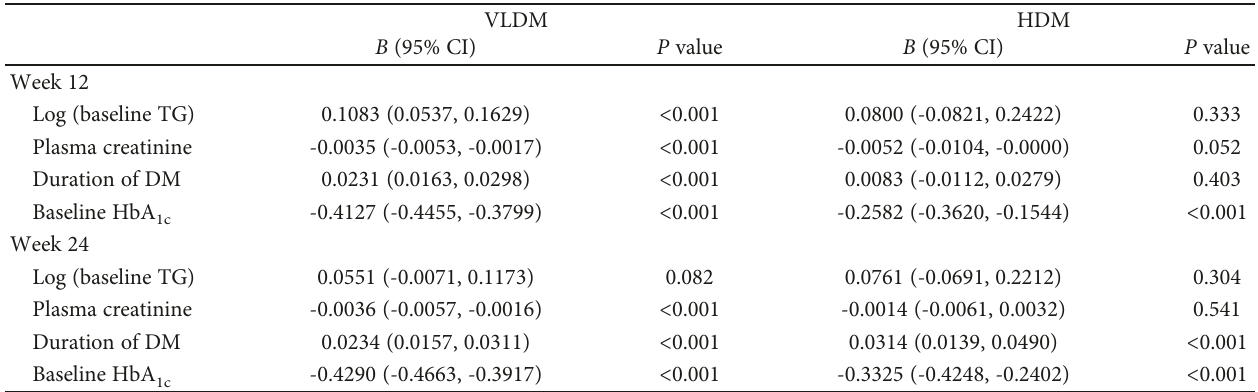
Table 3: Relationship between baseline characteristics and Δ HbA (FAS